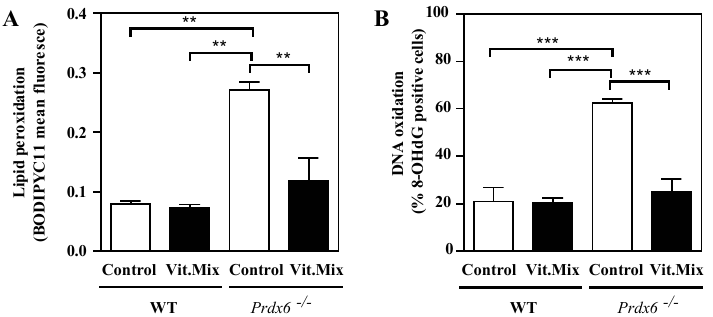
Figure 5. Lipid peroxidation ( A ) and DNA oxidation ( B ) in spermatozoa from WT or Prdx6 − / − males fed with control (open bars) and Vit. Mix (black bars) diets, respectively. ( A ) Lipid peroxidation measured by flow cytometry using a BODIPYC11 fluorescent probe. ( B ) DNA oxidation determined by the levels of 8-hydroxy-2’-deoxyguanosine (8-OHdG) in spermatozoa according to immunocytochemistry. ** p ≤ 0.01; *** p ≤ 0.001, two-way ANOVA and Tukey tests.